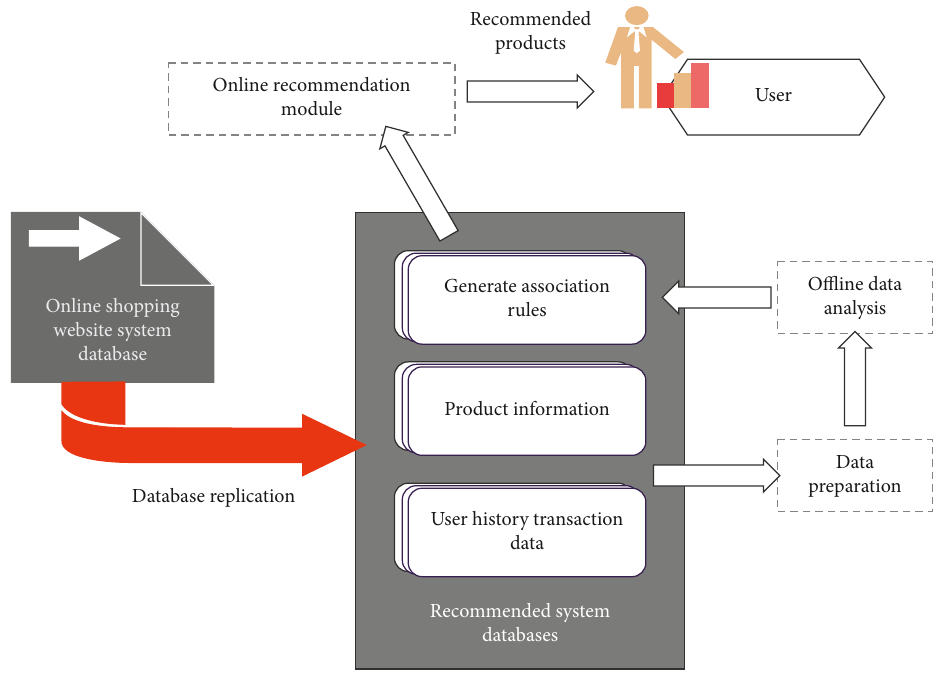
Figure 5: Architecture diagram of online shopping recommendation system.